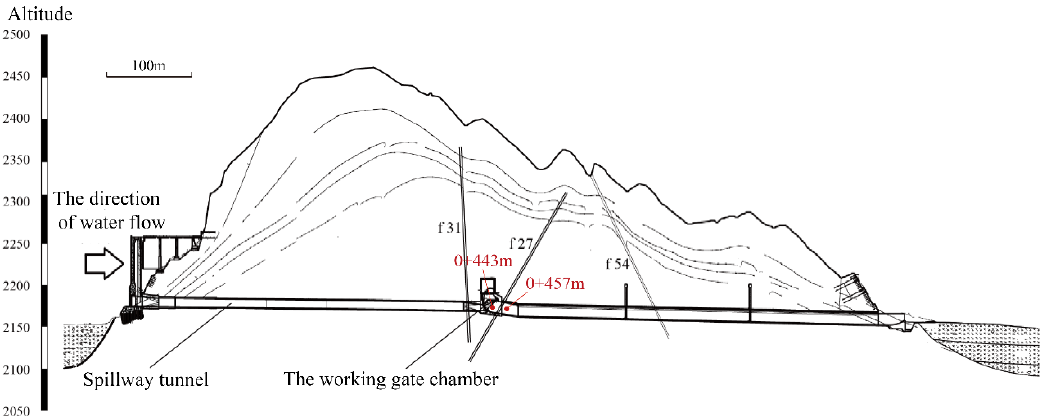
Figure 10. Geological section of the spillway tunnel.